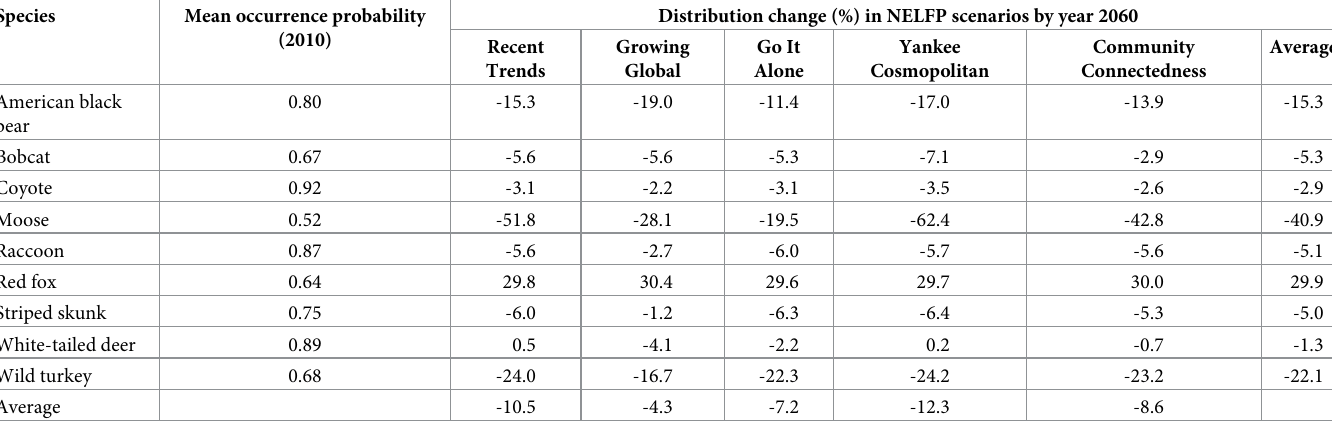
Table 1. Distribution change statistics for nine wildlife species in the New England region of the northeastern United States. Species